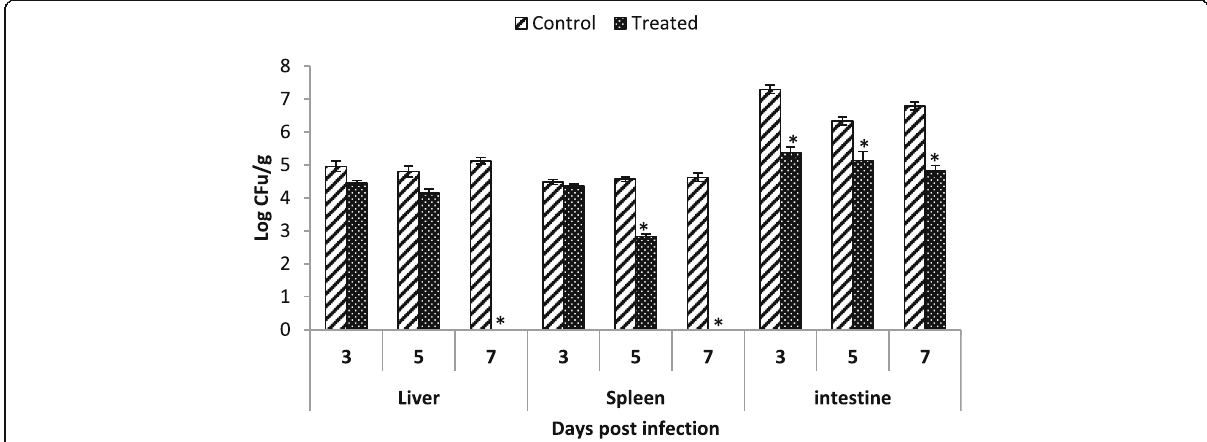
Fig. 2 Comparison of orally administered LB on spread of LM in mouse Organs (liver, spleen and intestine). Data was compared using independent sample t-test. Asterics on bar show significant differences at P <